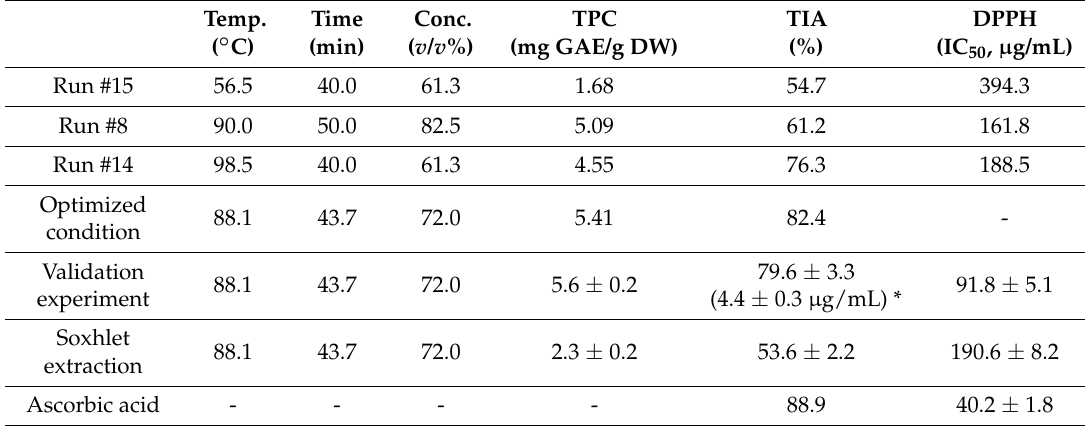
Table 4. Radical scavenging activity of mealworm extracts extracted by ethanol